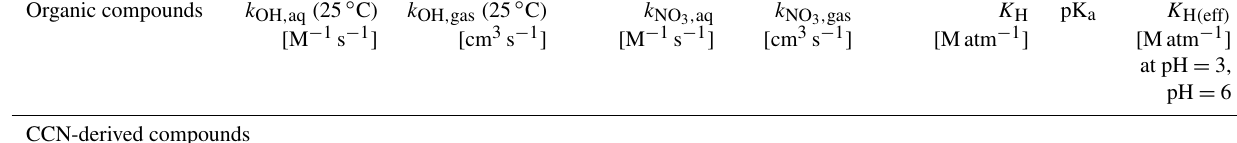
Table 1. Literature data on chemical rate constants in the aqueous ( k OH , aq ; k NO law constants ( K H ) and effective Henry’s law constants ( K H ( eff ) ) for acids at pH = 3 and pH = 6, respectively. Organic